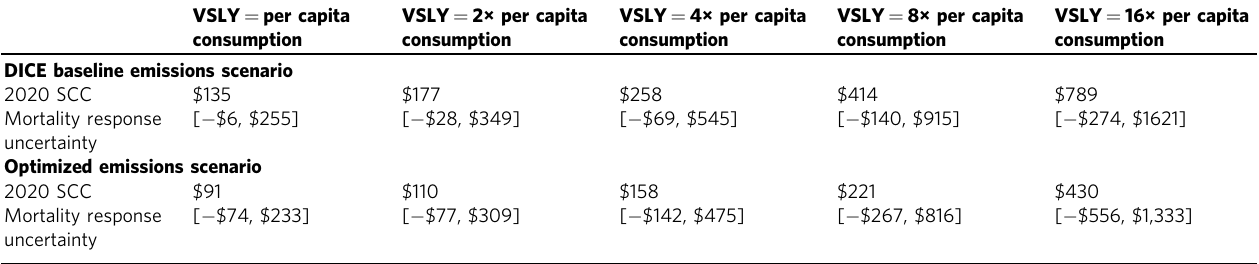
Table 2 2020 social cost of carbon